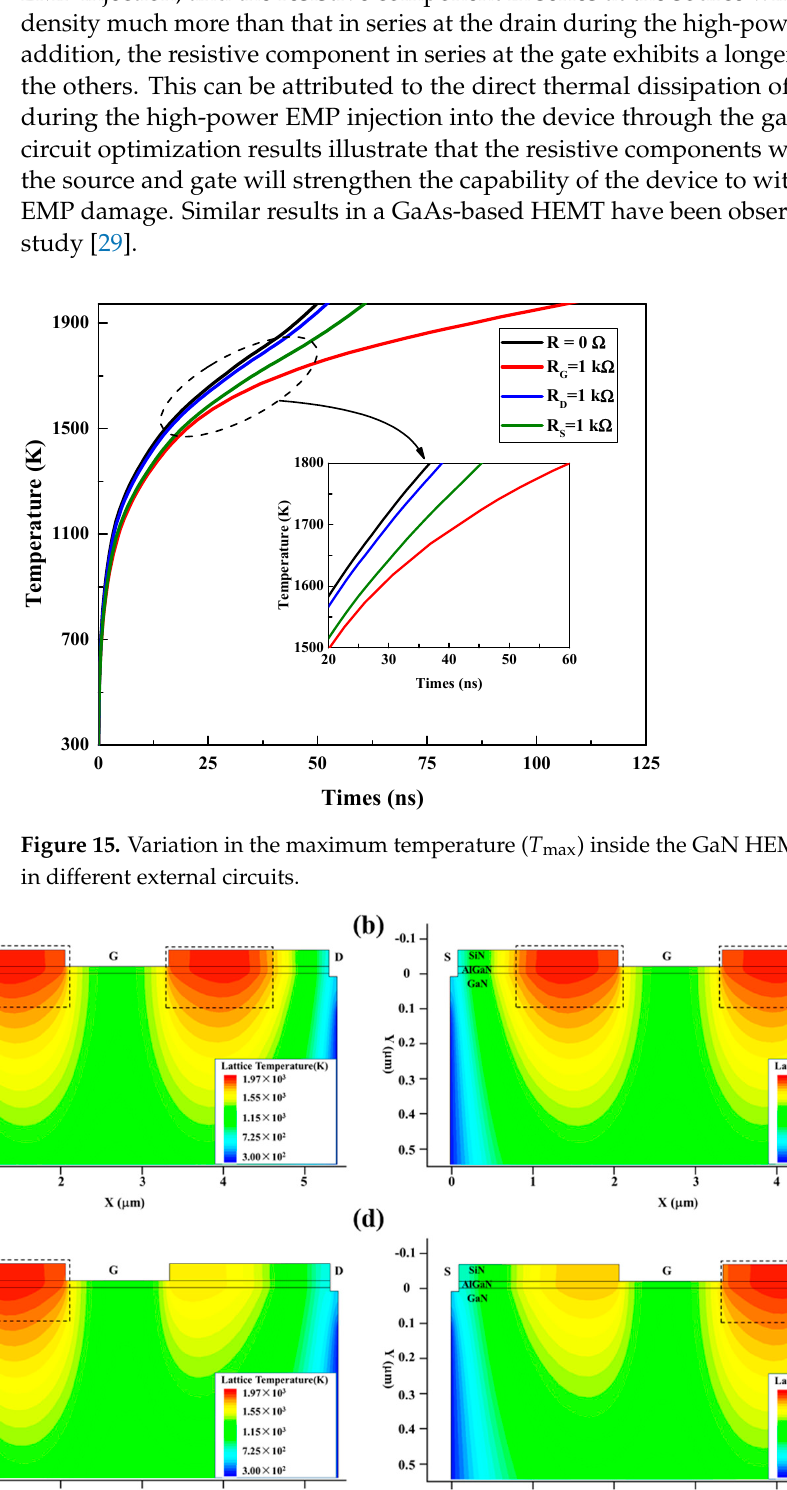
Figure 16. The thermal distribution of the GaN HEMT at the moment of burnout in different external circuits: ( a ) R = 0 Ω ; ( b ) R G = 1 k Ω ; ( c ) R D = 1 k Ω ; ( d ) R S = 1 k Ω .